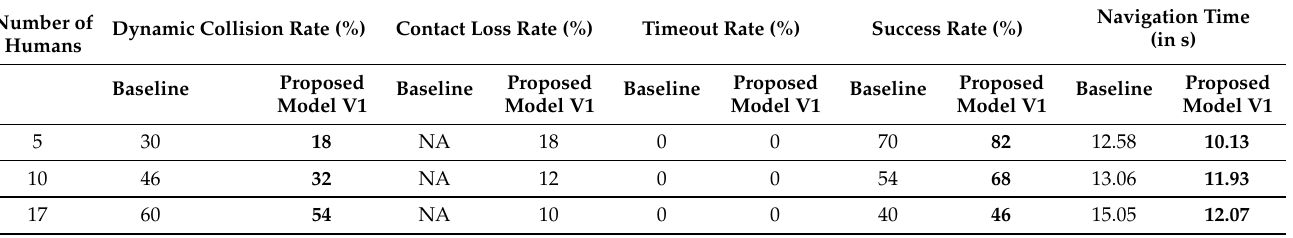
Table 1. Comparison between the baseline model [43] and the proposed model V1 with FOV 70 ◦